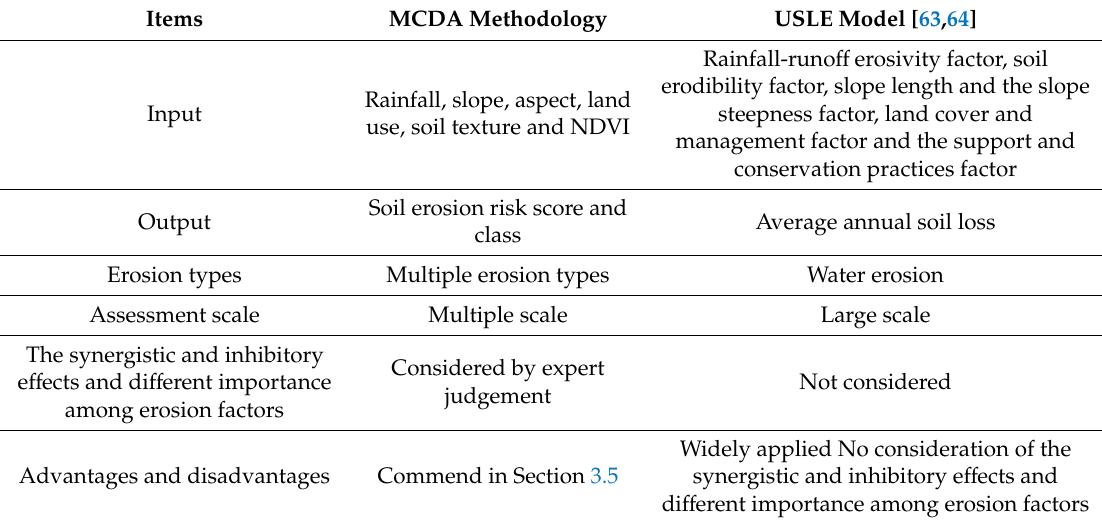
Table 5. Comparison between the MCDA methodology and USLE